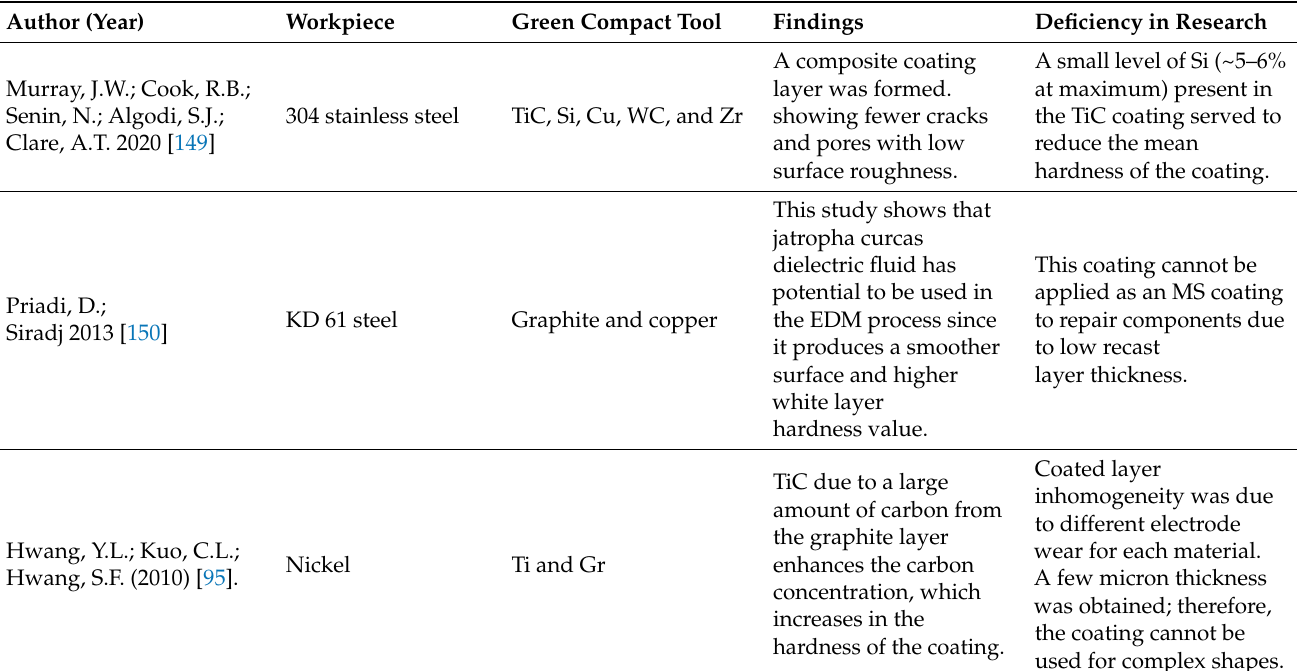
Table 7. Summary of the past literature work on EDC with a multi-layer